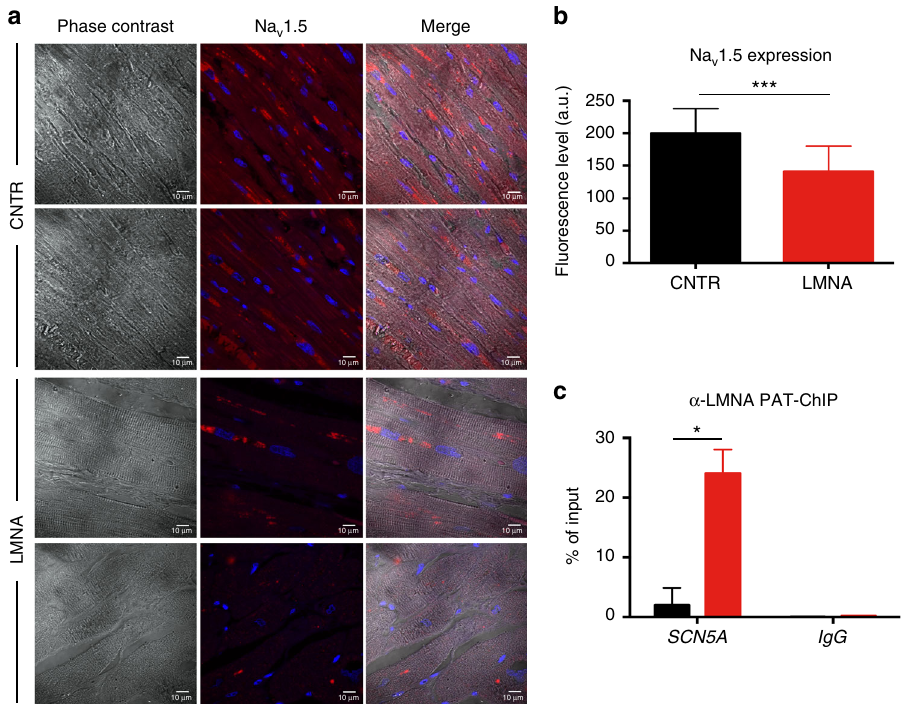
Fig. 6 Lamin A/C-mediated reduction of Na v 1.5 expression is con fi rmed in heart sections. a Immunostaining of paraf fi n-embedded heart sections from patients carrying the K219T mutation on Lamin A/C (bottom panels) and from two control subjects (top panels) targeting the Na v 1.5 sodium channel (red); nuclei were stained with DAPI (scale bars: 10 μ m). b Histogram showing the quanti fi cation of the red fl uorescent signal shown in a , corresponding to the Na v 1.5 protein, con fi rming reduced expression also in K219T-LMNA patient hearts. (a.u. is for arbitrary units). Data are relative to heart sections from three healthy controls ( n = 11) and four mutant samples ( n = 12). c PAT-ChIP analysis of heart sections from patients carrying the K219T mutation on LMNA (red bar) and from two control subjects (black bar), showing increased binding of Lamin A/C at the SCN5A promoter region in K219T-CMs. Chromatin was immunoprecipitated with an antibody against Lamin A/C and the resulting DNA was analysed by realtime PCR and presented as a percentage of input chromatin precipitated for the indicated region. All values are reported as means ± SD. * p < 0.05; *** p < 0.0001 (unpaired t